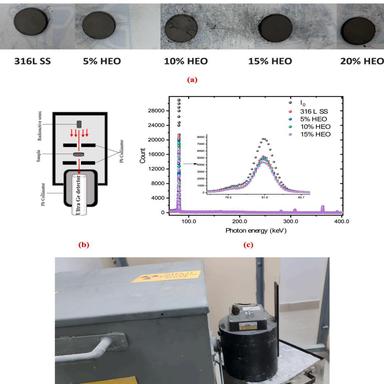
(a–d): (a) Physical appearances of the samples (b) Experimental set up for gamma transmission measurements (c) Absorption spectra of HEO samples for Ba-133 radioactive source (d) Experimental schemes for fast neutron dose measurements.